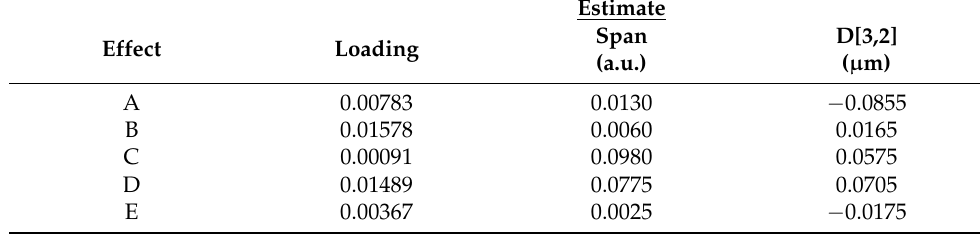
Table 3. The as-calculated estimates for the FFD design.